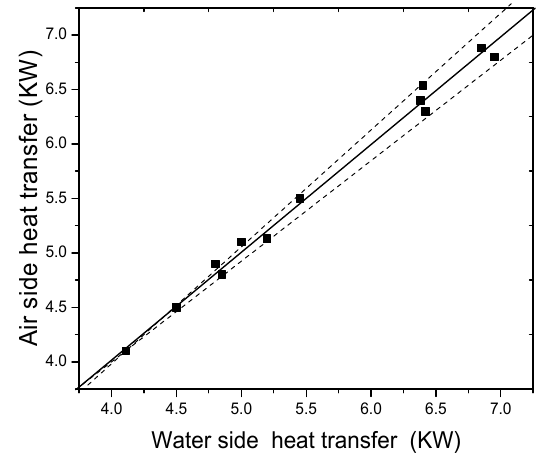
Figure 4. Heat balance comparison chart.